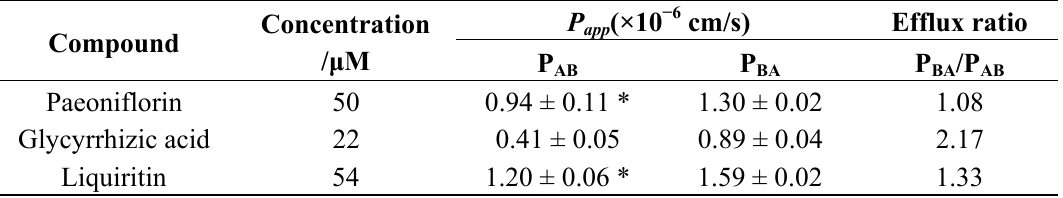
Table 2. Permeability of paeoniflorin in Shaoyao extract and glycyrrhizic acid, liquiritin in Gancao